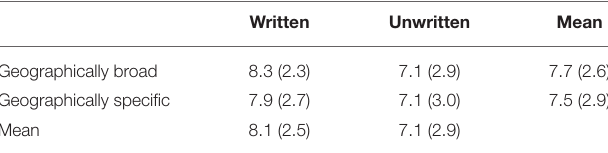
TABLE 1B | Mean score out of 10 (standard deviations) for the extent to which the description indicates a language comparing the presence of a writing system and geographic